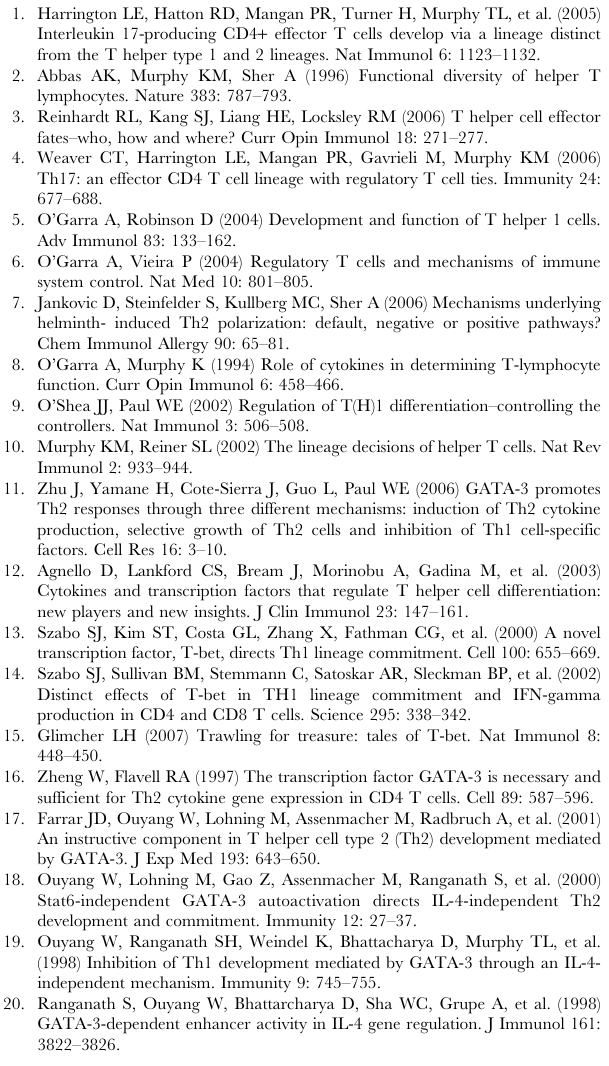
Table S3 Summary of the level of IL-4 produced (A) Percent of CD4 + T cells stained positive for intracellular IL-4 from three independent APC primed experiments described in Fig. 1 & 2. The ICS values were presented as flow cytometry plots in Supplemental Fig. 2A–C. Note that the values of IL-4 ICS are highly variable and are dependent on the types of conjugated antibodies used. (B) The level of IL-4 secreted by T cells activated with various APCs lines under different polarizing conditions. ELISA of IL-4 was carried out as described in Supplemental Table 2B. The mean and standard deviation was calculated and presented graphically in Fig. 2B.